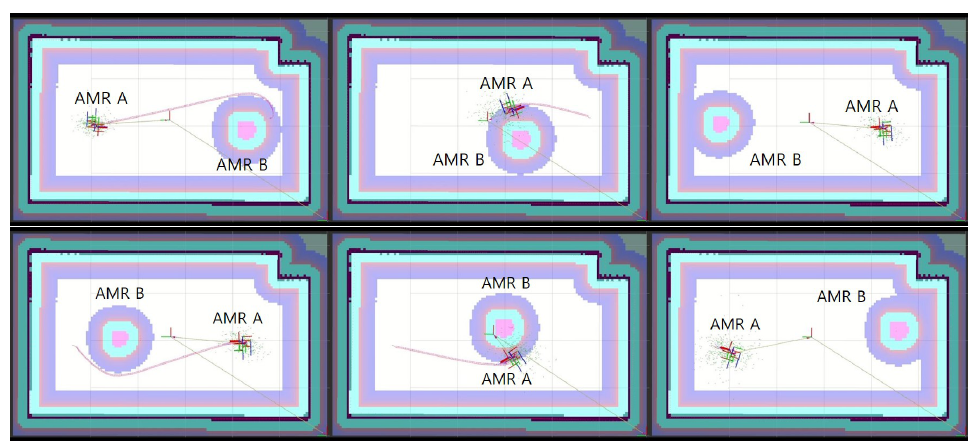
Figure 8. The cost maps of AMR A and B under the fleet layer.